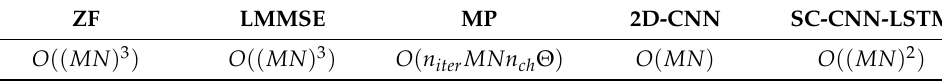
Table 5. Computational complexity